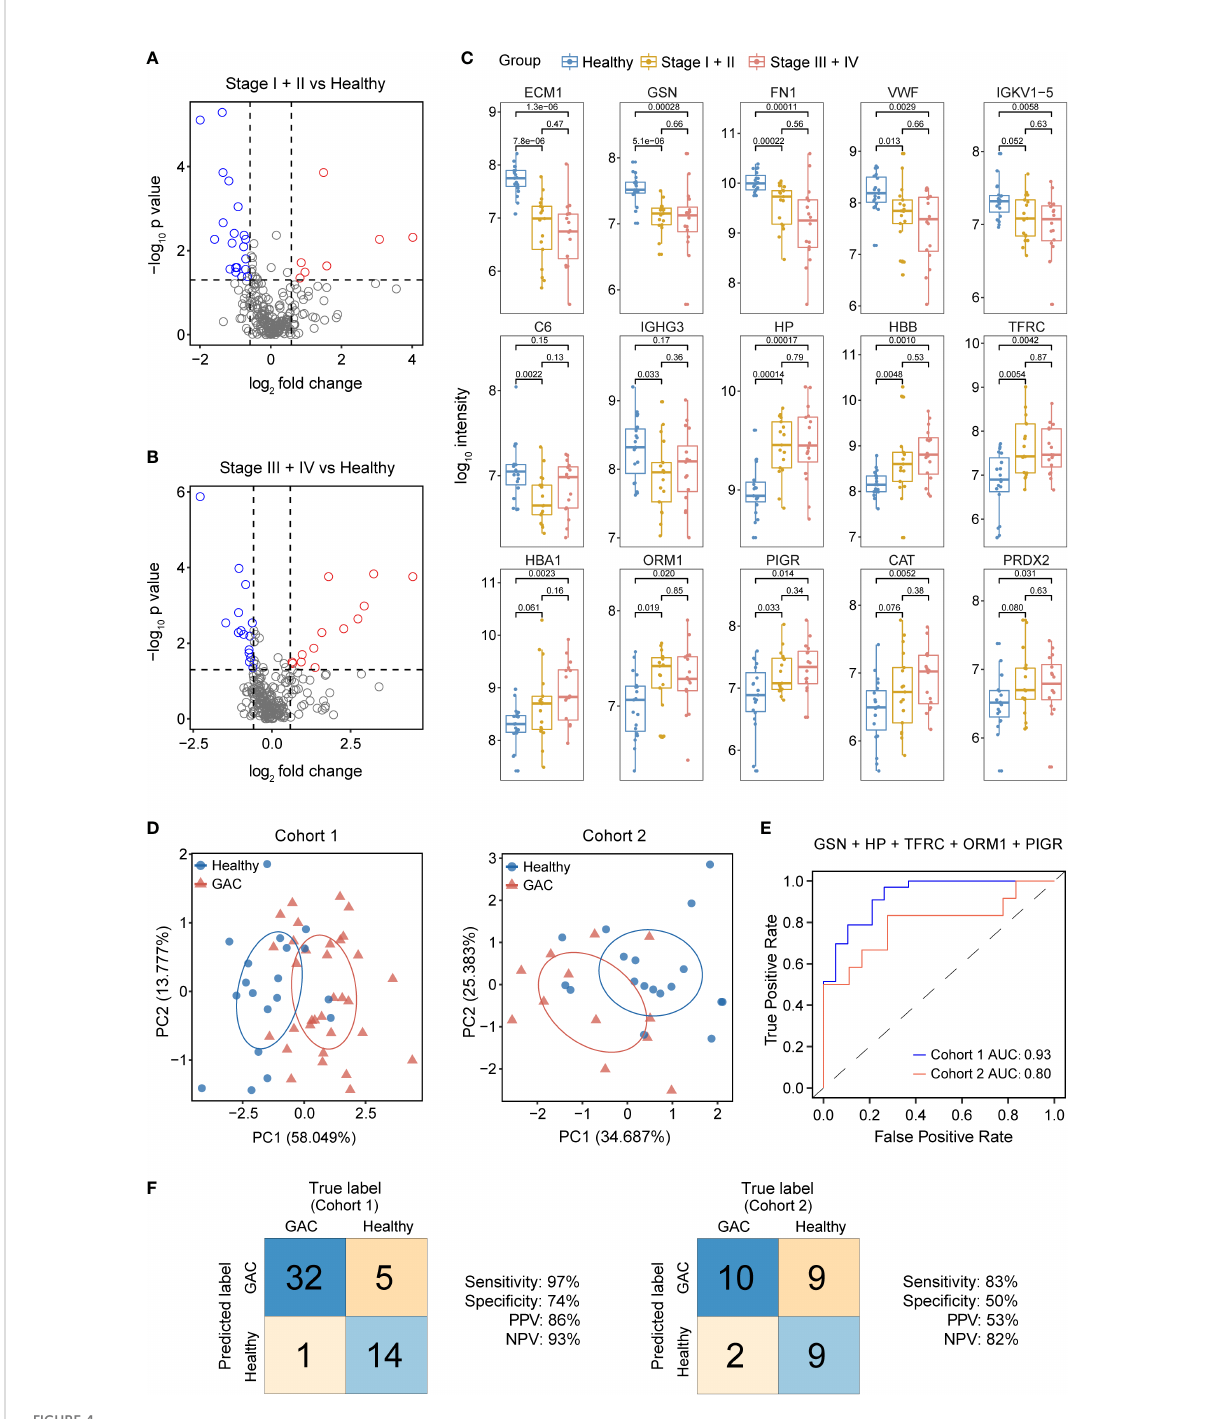
FIGURE 4 Discovery and validation of serum EV biomarkers for GAC diagnosis. (A) Volcano plot of signi fi cance value against log 2 -fold change between stage I + II GAC patients (N=17) and heathy controls (N=19) from cohort 1, with signi fi cantly changed proteins shown in blue or red circles. (B) Volcano plot of signi fi cance value against log 2 -fold change between stage III + IV GAC patients (N=16) and heathy controls (N=19) from cohort 1. (C) . Box-whisker and dot plots showing distribution of intensity values of 15 candidate proteins across three groups from cohort 1: healthy controls (N=19), GAC stage I + II (N=17) and GAC stage III + IV (N=16). (D) Principal component (PC) analysis of healthy control and GAC samples from cohort 1 (left) and cohort 2 (right) using 5 candidate proteins (GSN, HP, TFRC, ORM1 and PIGR). (E) ROC curves of the 5- protein logistic regression classi fi er for GAC diagnosis in cohort 1 and cohort 2. AUC, area under the curve. (F) Classi fi cation error matrix of the 5-protein logistic regression classi fi er from E in cohort 1 and cohort 2. The number of samples is noted in each